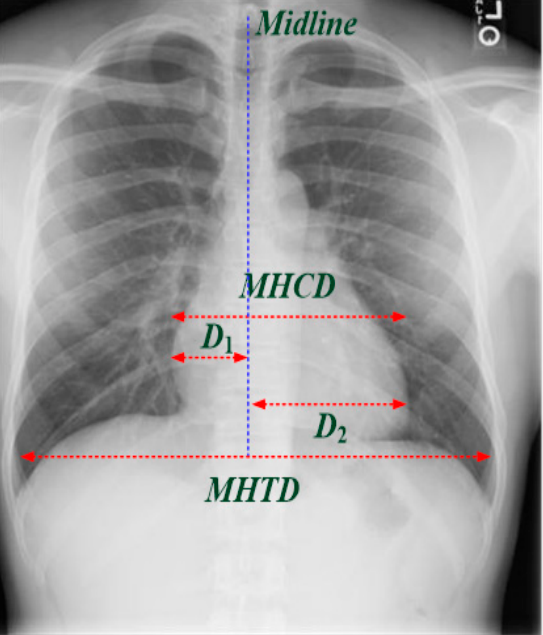
Figure 1. Measurement of cardiothoracic ratio (CTR) on PA CXR view for cardiomegaly assess- ment.